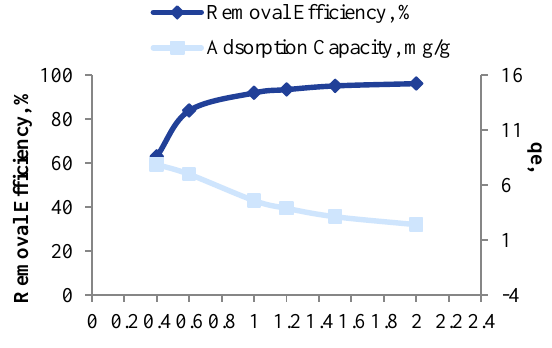
Figure 8. Comparison of the effect of adsorbent dose changes on the removal efficiency of chromium using MCh/Fe-Zr nanoparticles (density Cr 6+ = 5ppm, speed = 300 rmp, time = 30 minutes, temperature = 25 o C, and pH =